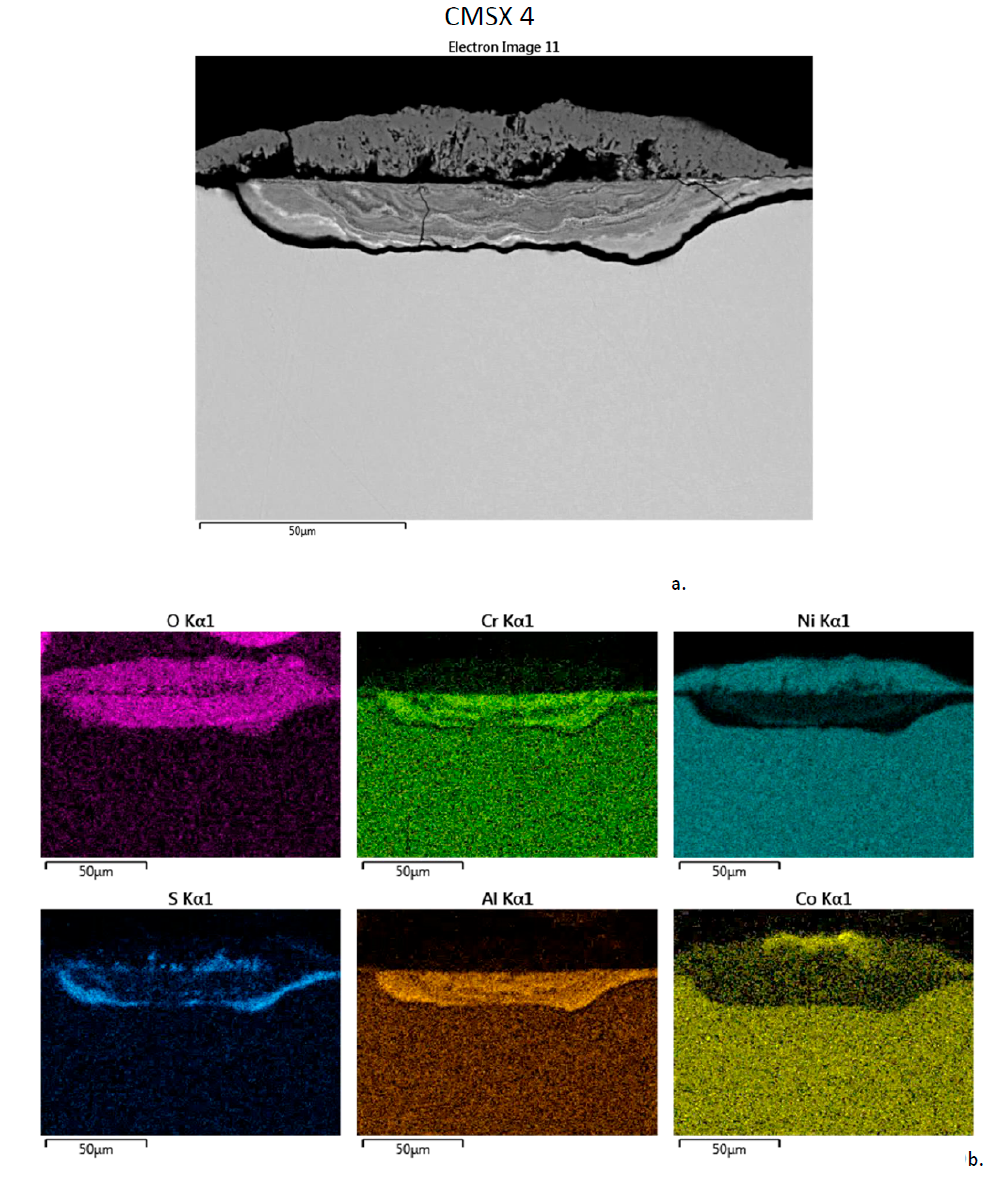
Figure 9. Cross-section of CMSX-4 sample of outer corrosion nodule and inner shallow corrosion pit after 300 h LTHC at 700 °C. ( a ) SE image showing two primary layers. ( b ) Elemental rasters for O, Cr, Ni, S, Al, Co showing inner Cr, Al, S bands in pit and outer Ni, Co bands in nodule.